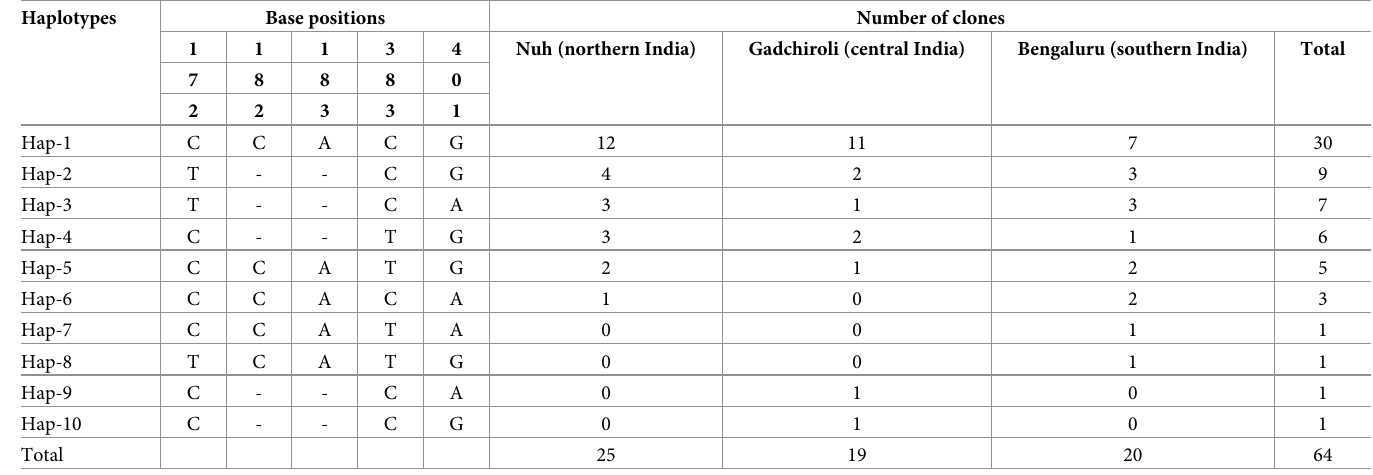
Table 2. Distribution of haplotypes in clonal DNA samples (nucleotide base position numbering based on the alignment displayed in Fig 2).